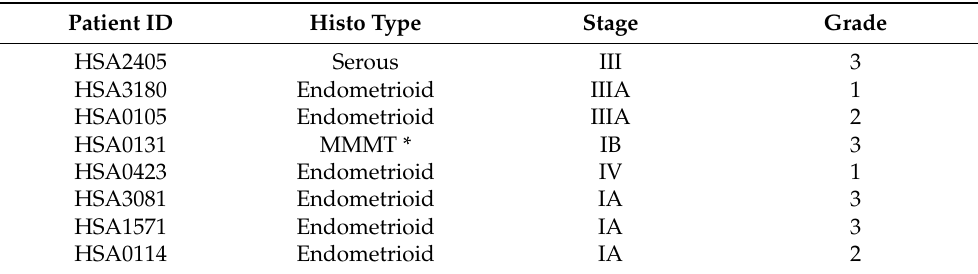
Table 1. Summary of clinicopathological parameters collected from the HSA Biobank patients. Patient ID Histo